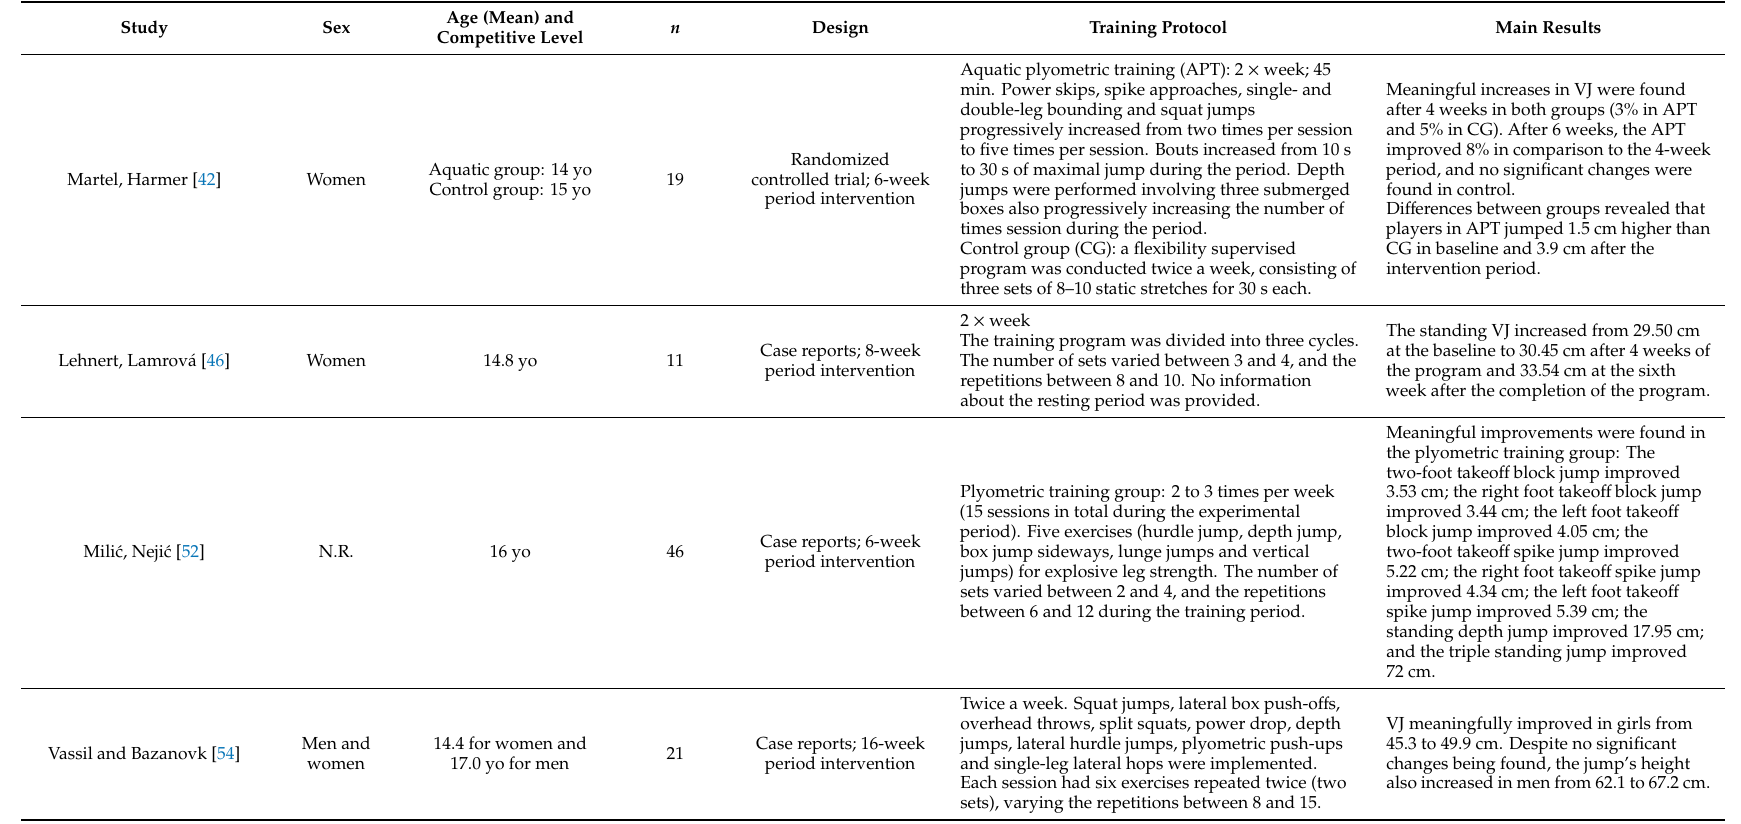
Table 2. Studies that investigated the e ff ects of plyometric training programs on vertical jump